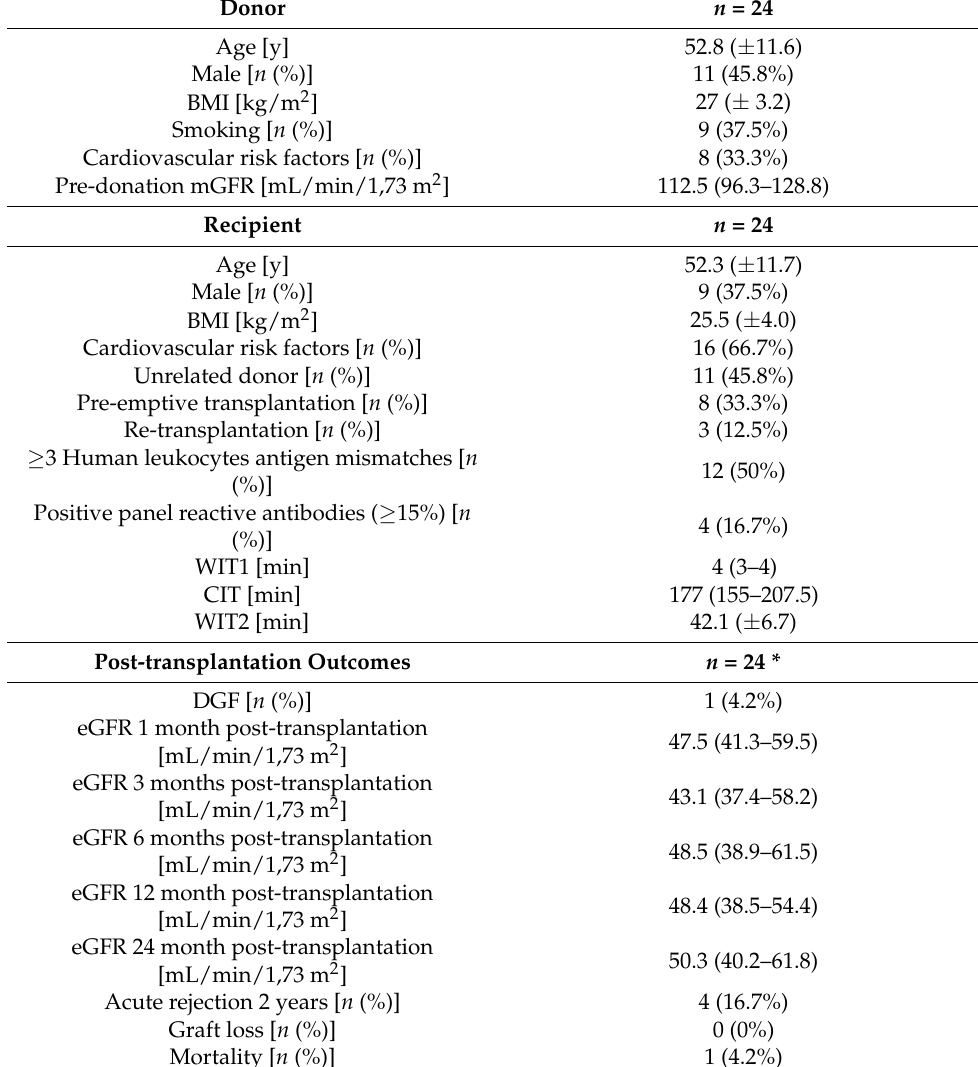
Table 1. Baseline demographic and clinical